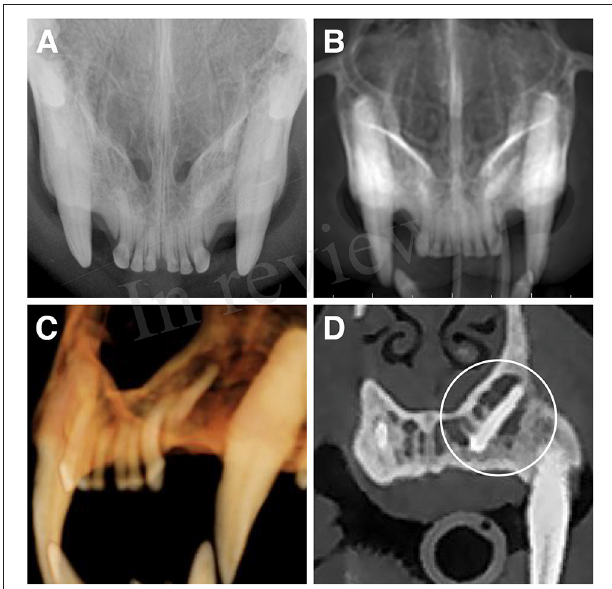
FIGURE 2 | Supernumerary left maxillary third incisor tooth with abnormal eruption . A supernumerary left maxillary incisor tooth was identified as impacted within the left incisive bone. This dentoalveolar lesion was only clearly identified via the MPR method. (A) maxillary occlusal dental radiographic view, (B) reconstructed panoramic view with the axis of the skull adjusted for orientation of the left and right maxillary first through third incisor teeth, (C) tridimensional (3-D) rendering in tooth mode of the left incisive region, (D) custom cross-section multiplanar reconstruction decisively showing the supernumerary impacted left maxillary third incisor tooth